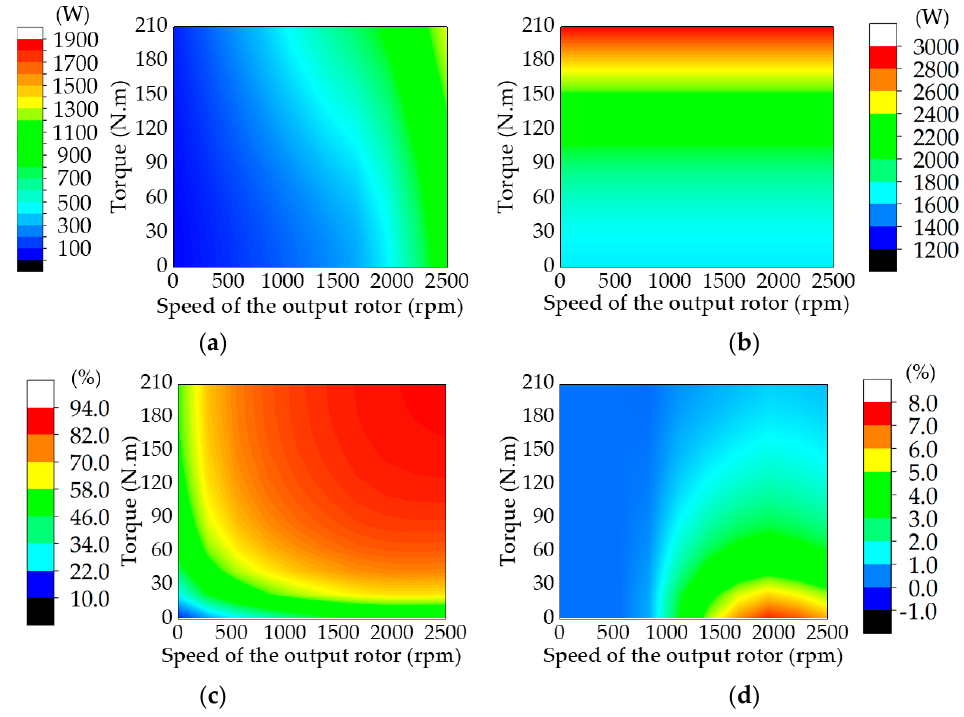
Figure 10. Loss and efficiency maps in the constant torque region according to the winding frequency when the amplitude of the inner winding current is adjusted and the outer winding current is fixed at the rated current (168 Arms). ( a ) Minimum iron loss map; ( b ) Copper loss map; ( c ) Maximum efficiency map; ( d ) Efficiency difference between Type III and Type I.